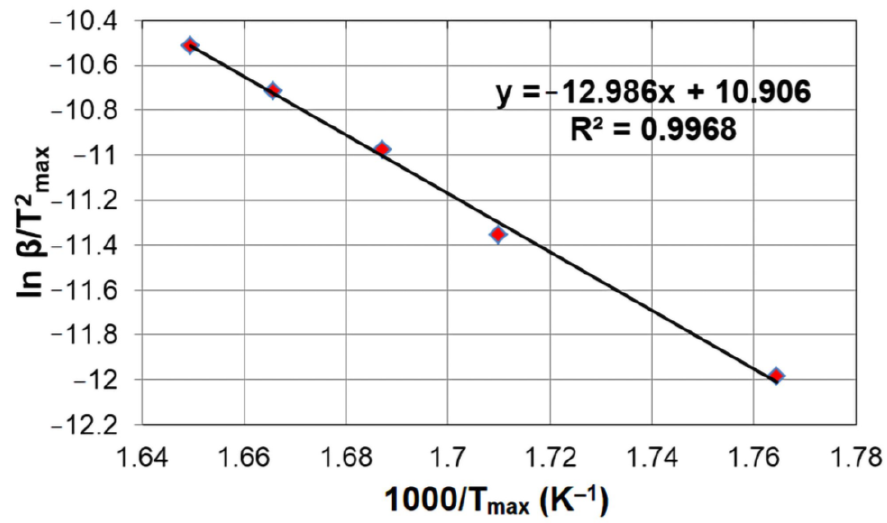
Figure 4. Plotting of Kissinger kinetic method for EE.